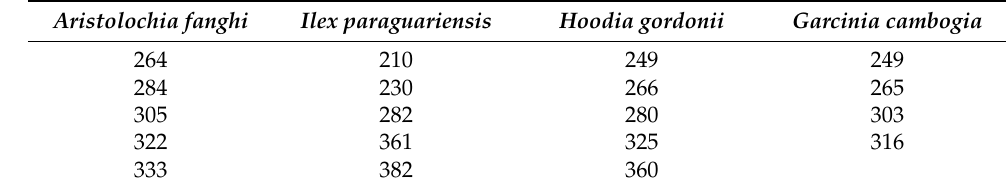
Table 1. Selected wavelengths (nm) for all 4 plants.